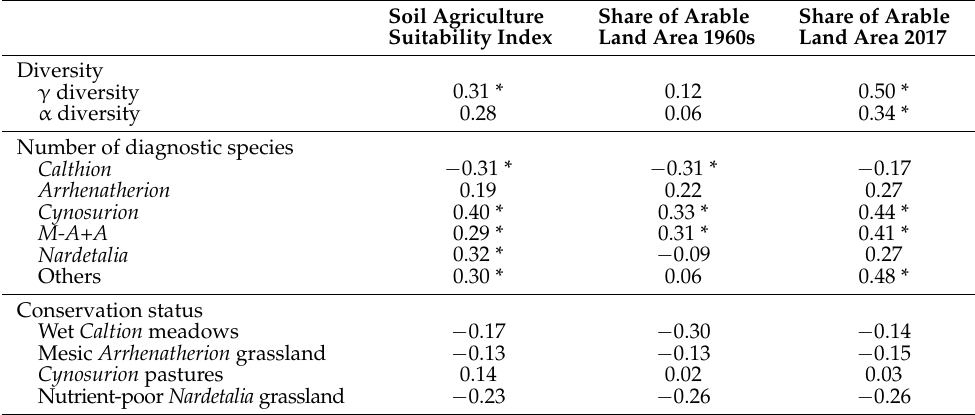
Table 3. Spearman rank-correlation coefficients between grazing site diversity metrics, habitat quality and grazing site characteristics. Abbreviations: M - A + A -species diagnostic for the Molinio- Arrhenatheretea class and for the Arrhentheretalia